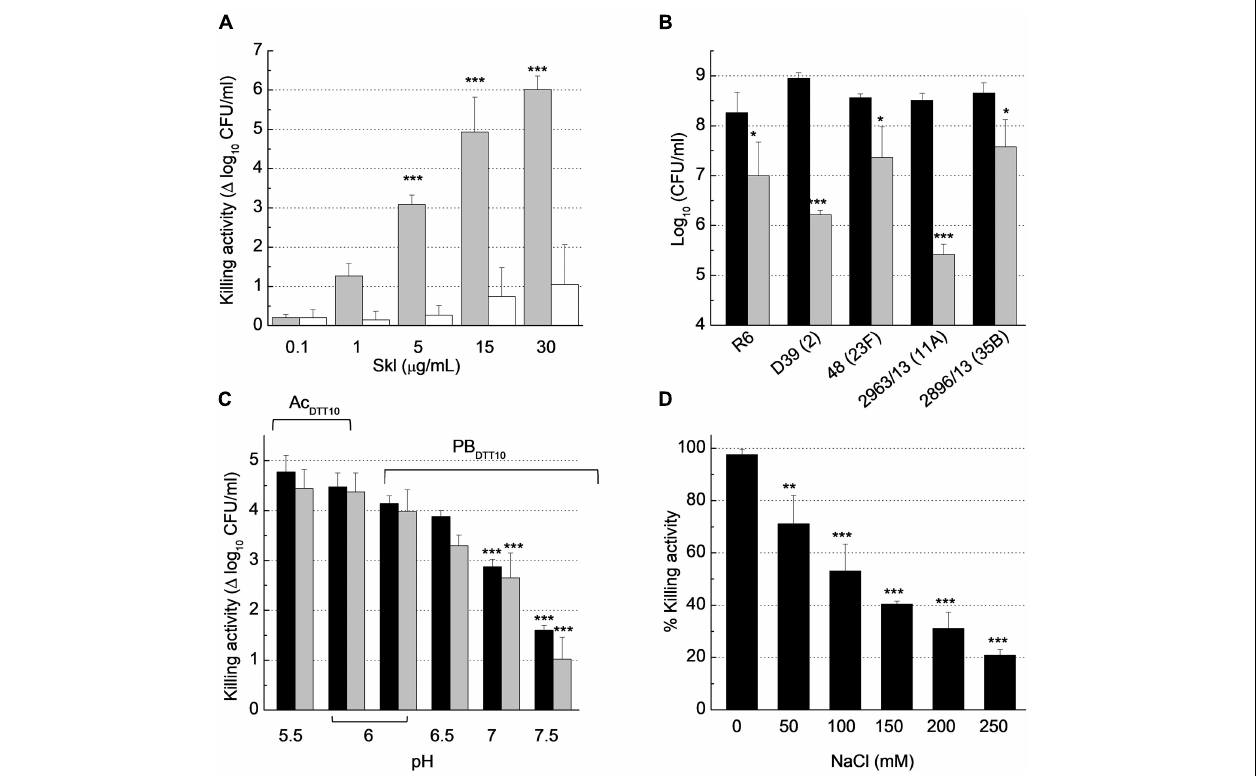
FIGURE 7 | Biochemical characterization of Skl anti-pneumococcal activity. Bacterial suspensions were treated with buffer (control) or with Skl for 60 min before dilution and plating on blood agar for viable cell determination (CFU/ml). (A) Dose-dependent decrease of S. pneumoniae R6 viability upon treatment with Skl WT or the Y264H mutant (gray and white bars, respectively) in PBS DTT 10 (137 mM NaCl, 2.7 mM KCl, 10 mM Na 2 HPO 4 , 1.8 mM KH 2 PO 4 , 10 mM DTT, pH 6.8) at 37 ◦ C. (B) Killing activity of Skl WT (1 µ g/ml) against various pneumococcal strains (PBS DTT 10 , 37 ◦ C) (serotypes indicated in parenthesis; black bars represent controls). (C) Effect of pH on the killing activity of Skl (2.5 µ g/ml) against D39 strain, measured at 30 ◦ C (black bars) and 37 ◦ C (gray bars) in PB DTT 10 or Ac DTT 10 buffer (20 mM sodium acetate, 10 mM DTT). (D) Influence of NaCl concentration on the bactericidal activity of Skl (1 µ g/ml) against D39 cells (PB DTT 10 , pH 6.0, 30 ◦ C). Statistical analysis for (A,C) was performed using two-way ANOVA followed by Sidak post-test to compare Skl WT and the Y264H mutant, and with PB DTT 10 (pH 6.0) at the same temperature, respectively. No significant differences were found between 30 and 37 ◦ C. In (B) , treated and untreated bacteria were compared by a two-tailed t -test, and in (D) one-way ANOVA was performed followed by Dunnet’s post-test taking 0 mM NaCl as reference. Error bars represent standard deviations from three independent experiments. Asterisks mean a significant difference (* p < 0.05; ** p < 0.01; *** p <